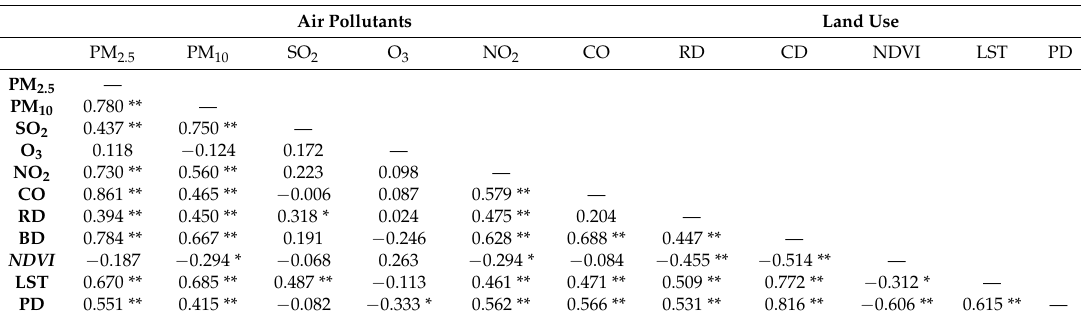
Table 2. Spearman’s rank correlation between air pollutants and land